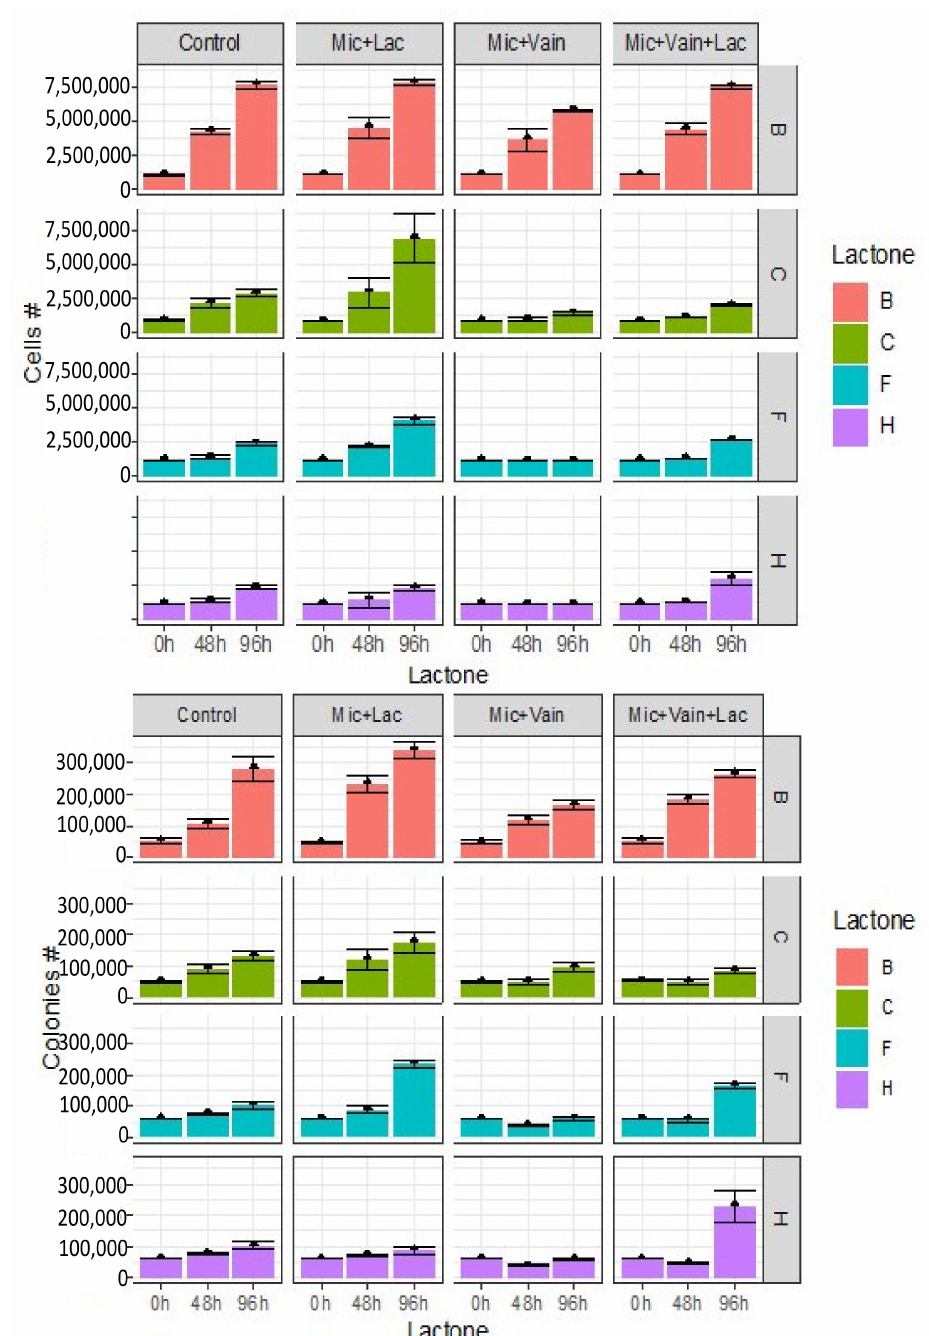
Figure 5. Effect of vanillin on cell proliferation (above) and colony formation (below) of the lactones N-(3-oxododecanoyl) ( B ), N-hexanoyl ( C ), N-dodecanoyl ( F ), and N-(3-oxodecanoyl)-L-homoserine ( H ), together with the inhibitor (vanillin). Mic: M. aeruginosa , Vai: vanillin, Lac: Lactone. Overall, vanillin was an inhibitor of cell proliferation and colony formation. Its effect even irreversibly blocks the inducing effect of lactones C and